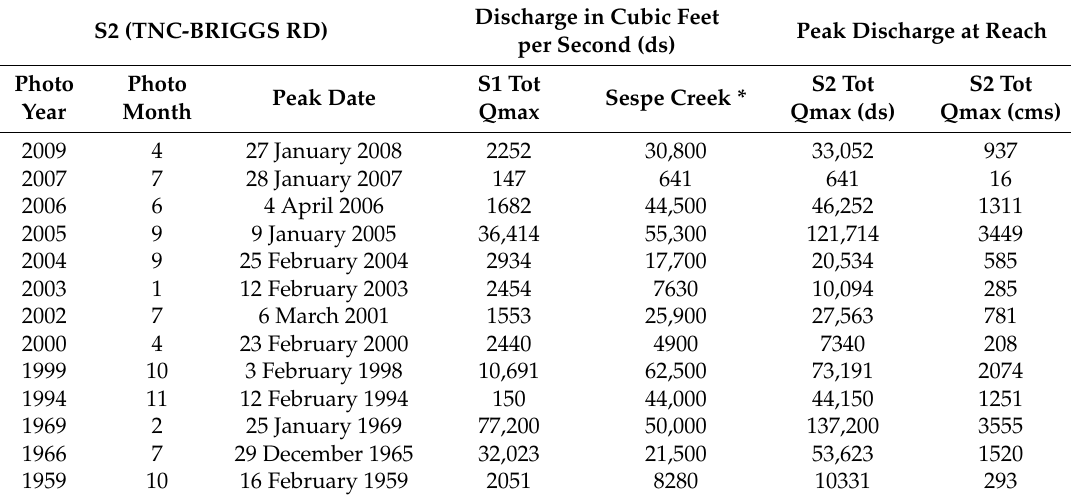
Table A2. Calculated values for magnitude of peak discharge for specific flooding events at S2 study